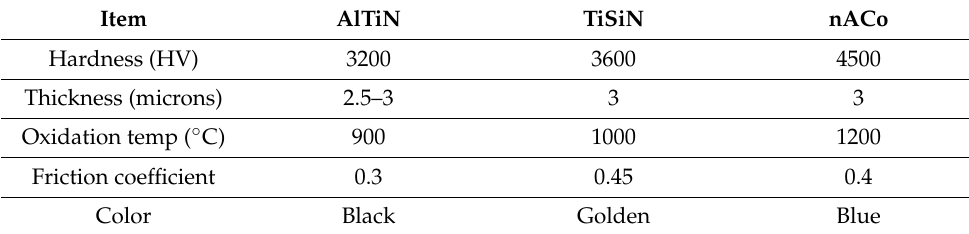
Table 5. Coatings specification used in the study.